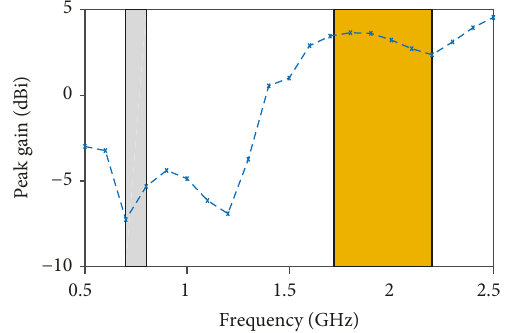
| of the proposed MIMO 11